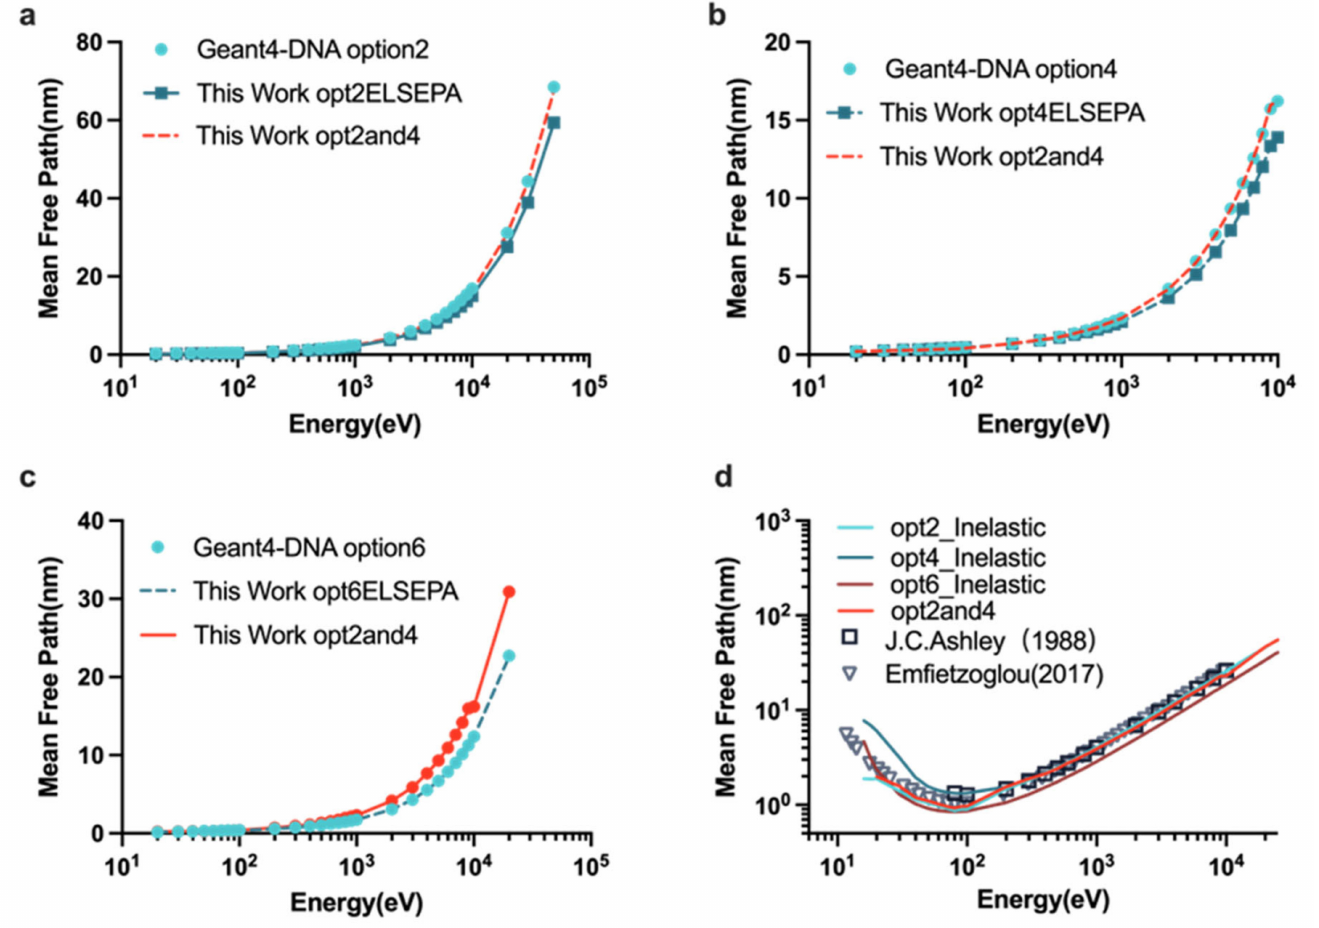
Figure 1. MFP simulations for electrons in liquid water as a function of initial electron energy from 12 eV to 50 keV. ( a ) The total MFP simulations for option2, option2 with ELSEPA and opt2and4. ( b ) The total MFP simulations for option4, option4 with ELSEPA and opt2and4. ( c ) The total MFP simulation for option6, option6 with ELSEPA and opt2and4. ( d ) The inelastic MFP for the option with the ELSEPA model was calculated and compared with the experimental data adapted from Ref. [62] Ashley et al., 1988, and the value adapted from Ref. [63] Emfietzoglou et al.,